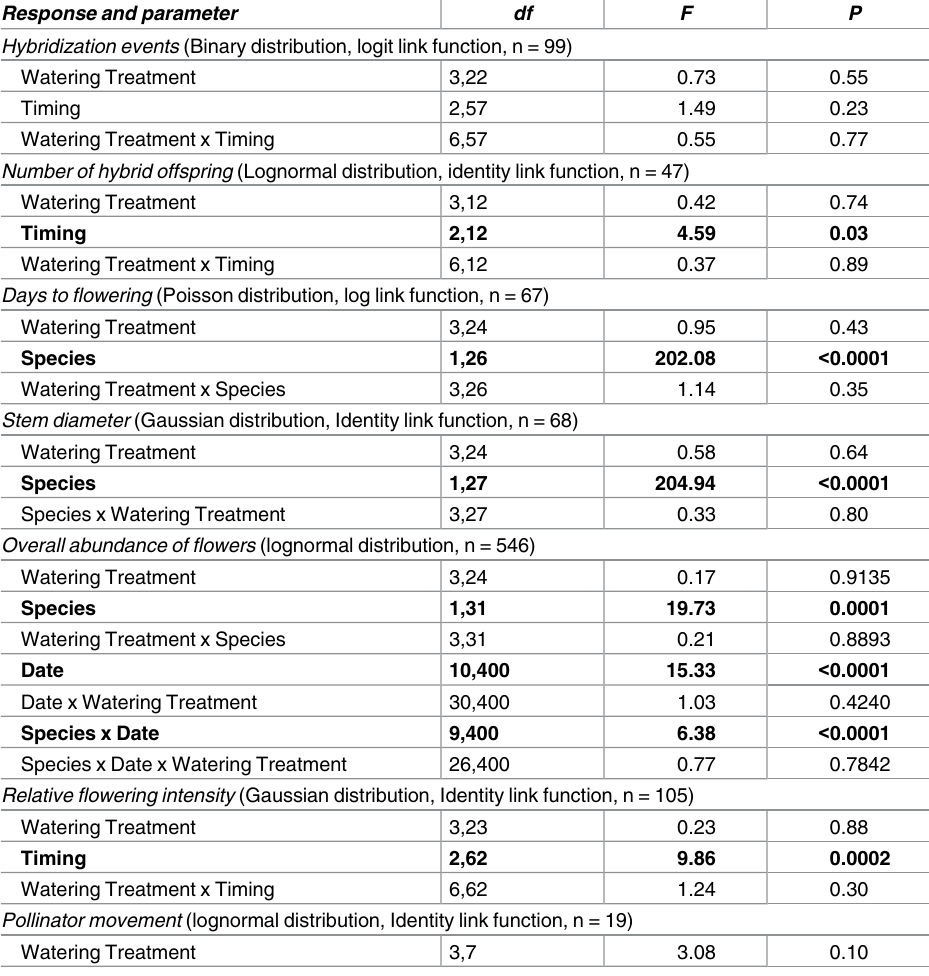
design where treatments are applied at different scales, we used different errors to test our three factors and interactions therewith. We tested the effects of our main plot factor—water- ing treatment—using its interaction with block. Subplot factors (usually species, sometimes timing) and their interaction with watering treatment were tested with an interaction term including block, watering treatment, and the factor being tested. Split-split plot factors and interactions therewith were tested with the full four-way interaction between block, watering treatment, species, and collection time when degrees of freedom were available. In cases when we were limited in the number of degrees of freedom, we removed all factor interactions with block from the model.